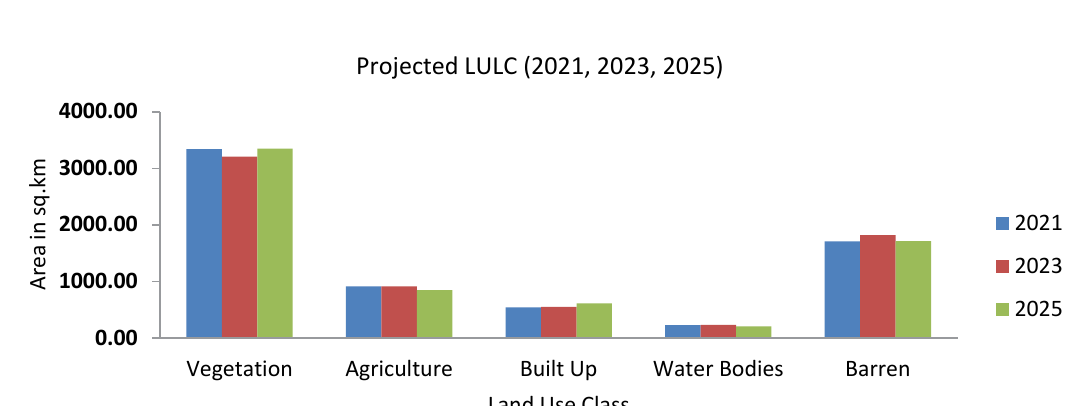
Fig. 4: Projected LULC map of 2021, 2023 and 2025